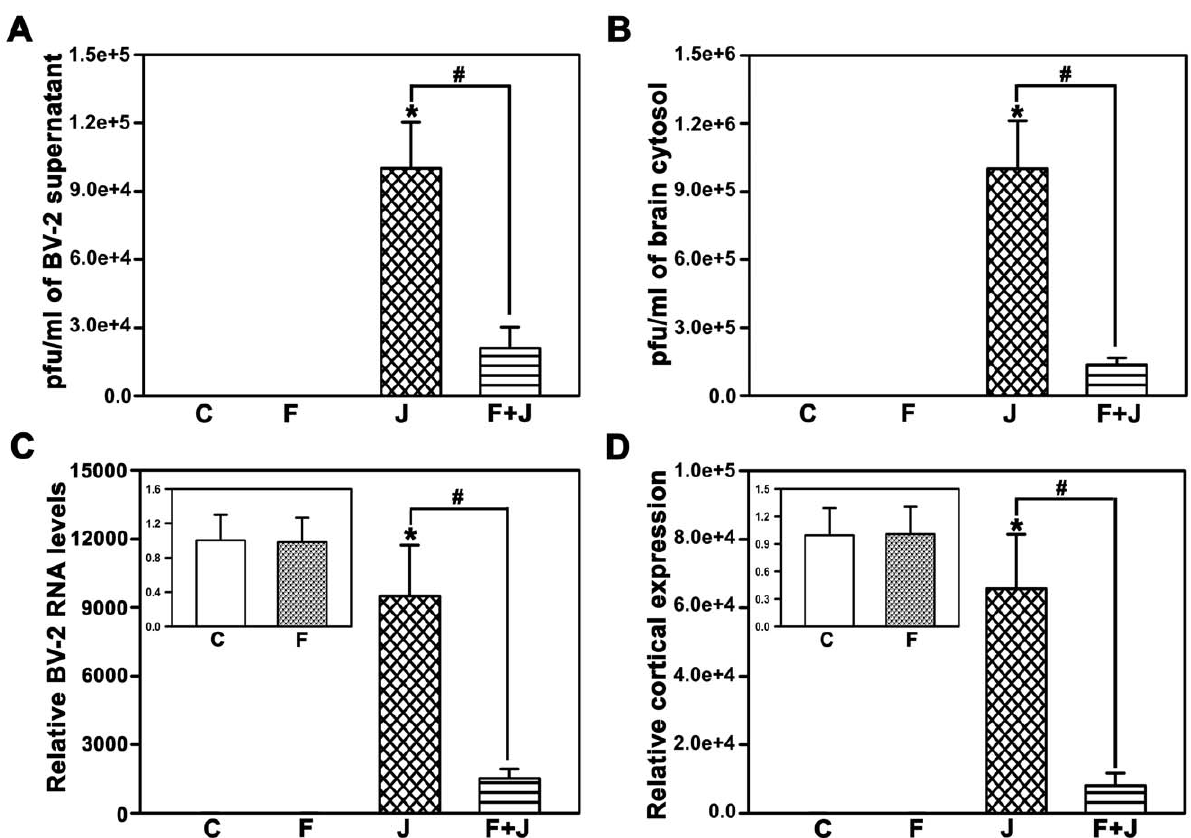
Figure 6. Fenofibrate reduces JEV replication both in vitro, in BV-2 cells and in vivo, in mouse brain. Infection with JEV significantly increased the viral titer in the culture medium of BV-2 cells (A) and the cytosol (B) prepared from the brains of BALB/c mice infected with JEV. Pretreatment with fenofibrate significantly decreased the JEV induced viral replication, both in vitro in BV-2 cells (A) and in vivo, in mouse brain (B). There was a corresponding decrease in the mRNA levels of GP78, the coat protein of JEV following fenofibrate treatment both in BV-2 cells (C) and in the brains of BALB/c mice (D) compared to JEV alone as quantitated by qRT-PCR. mRNA levels for all treatments are expressed relative to controls. Insets in C,D depict the levels of mRNA of GP78 in control and fenofibrate treated brains. Data is represented as (C) vehicle control, (F) fenofibrate, (J) JEV, (F + J) fenofibrate + JEV treated mouse brain cortex (n=8 per group, *and # p , 0.05).